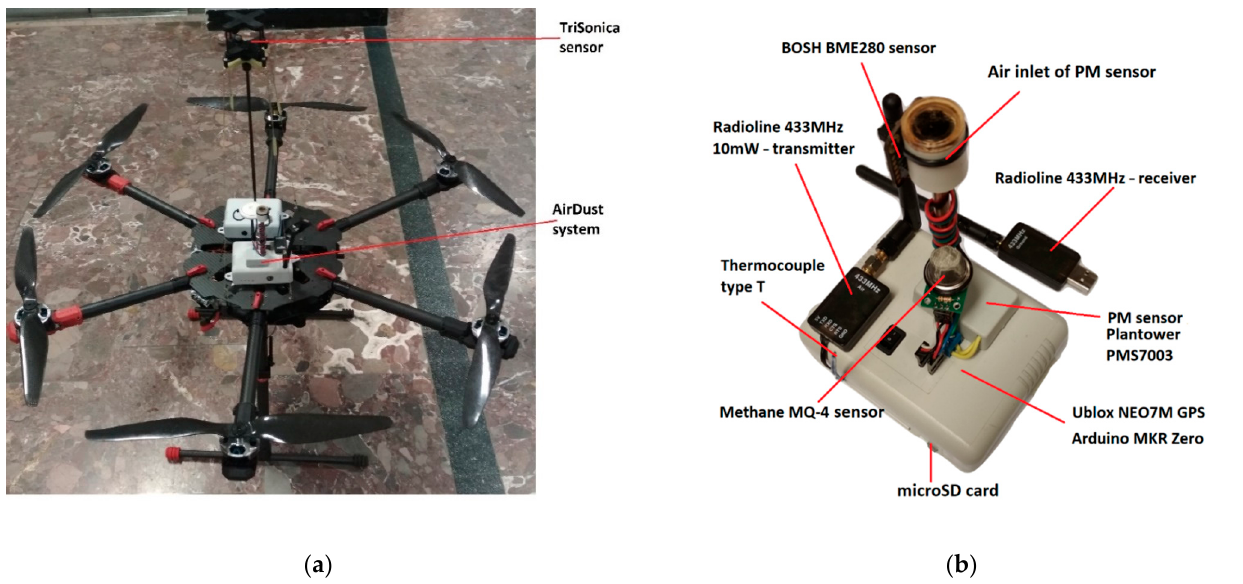
Figure 1. Unmanned aerial vehicle (UAV) equipped with air quality and meteorological components sensors ( a ) and AirDust ultra-light measurement system ( b ) for temperature, relative humidity, atmospheric pressure, particulate matter and GPS position equipped with a data logger.